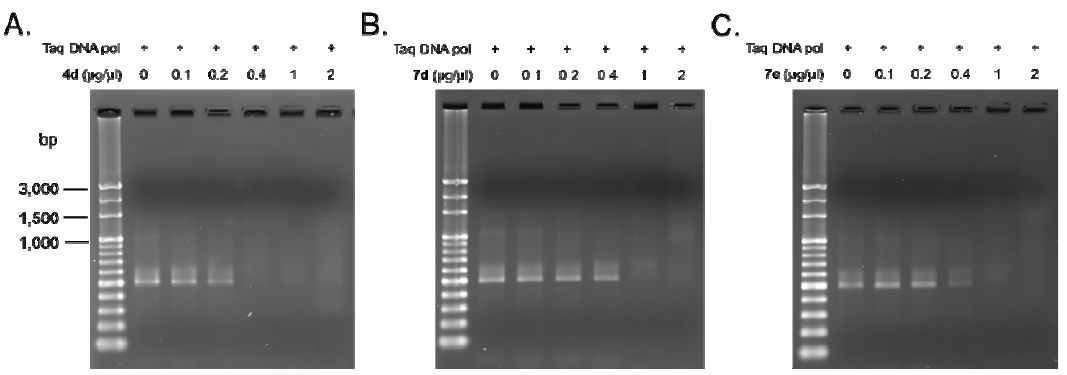
Figure 5. Antibacterial mechanism of compounds 4d ( A ), 7d ( B ), and 7e ( C ).